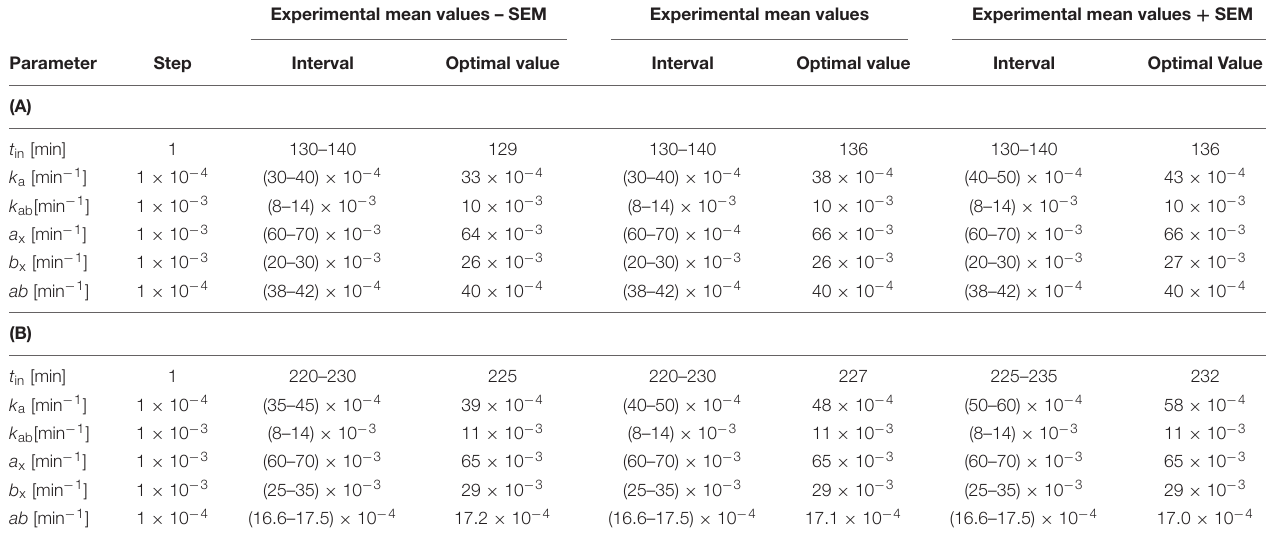
TABLE 2 | Estimated intervals of possible values of parameters of model (Equations 1–4) for (A) healthy volunteers after 180-mg ticagrelor loading dose (344.453 µ mol) and (B) healthy volunteers after 180-mg ticagrelor loading dose administered with 5-mg